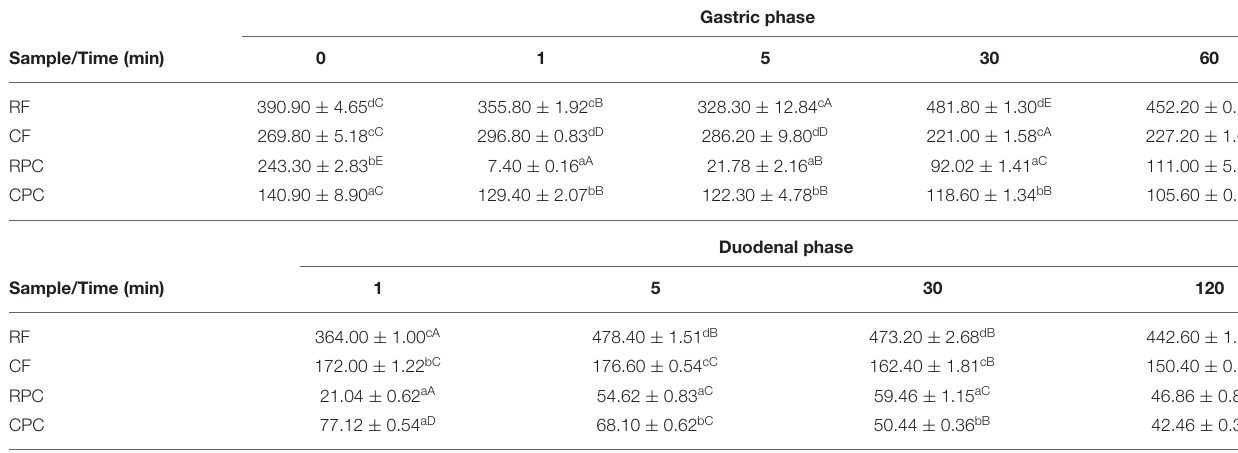
TABLE 6 | Particle size distribution ( µ m) of 90% of total particles while in vitro protein digestion (IVPD).